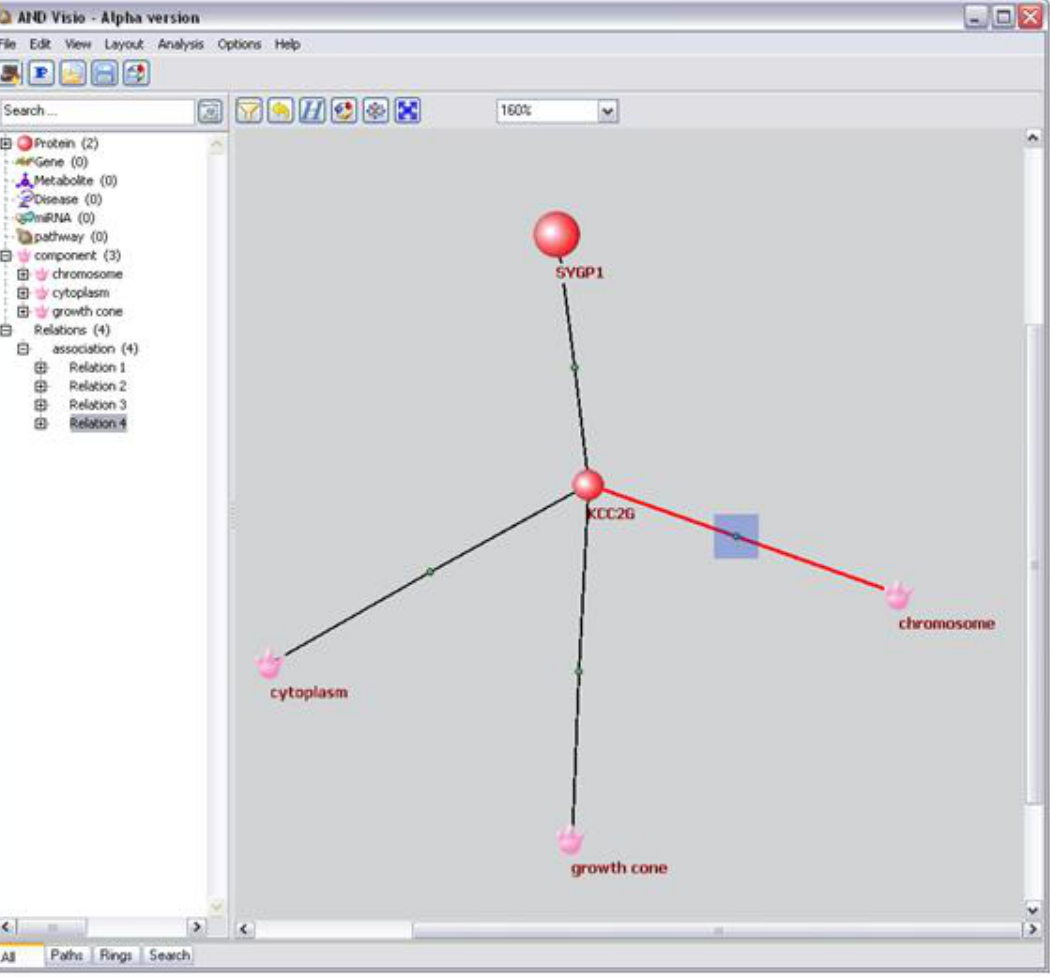
Figure 8: The protein interaction network in ANDVisio shows also the direct connection between SYGP (SYNGAP1) and KCC2G, which is part of the same protein complex (2.7.11.17) as KCC2A (CAMK2A). The localization result of KCC2G could be assigned as well to SYGP1: chromosome, cytoplasm and growth